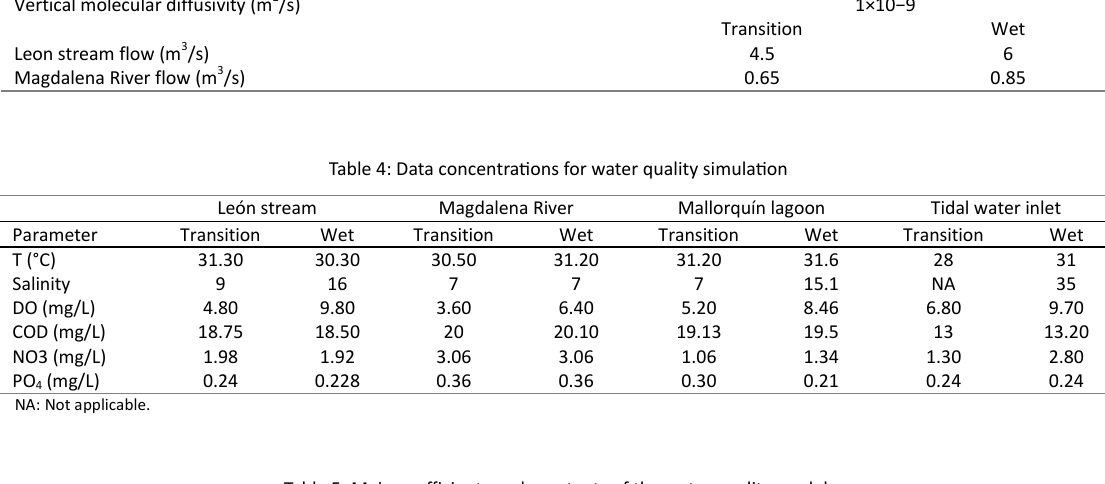
Table 5: Main coefficients and constants of the water quality model.